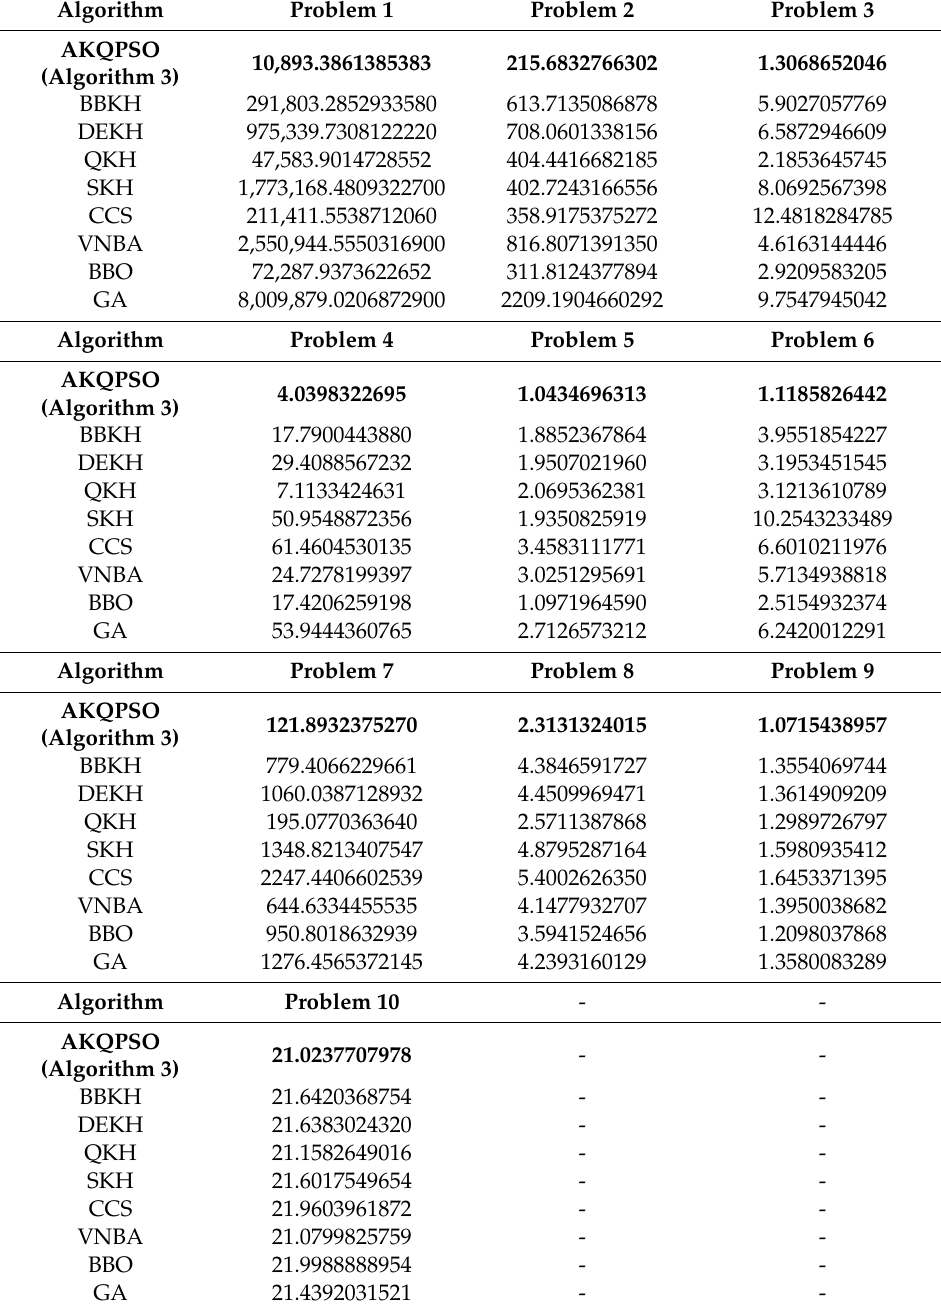
Table 3. The minimum value of annealing krill quantum particle swarm optimization (AKQPSO) and other algorithms in the 100-Digit Challenge. BBKH, biogeography-based krill herd; DEKH, di ff erential evolution KH; QKH, quantum-behaved KH; SKH, stud KH; CCS, chaotic cuckoo search; VNBA, variable neighborhood bat algorithm; BBO, biogeography-based optimization; GA, genetic